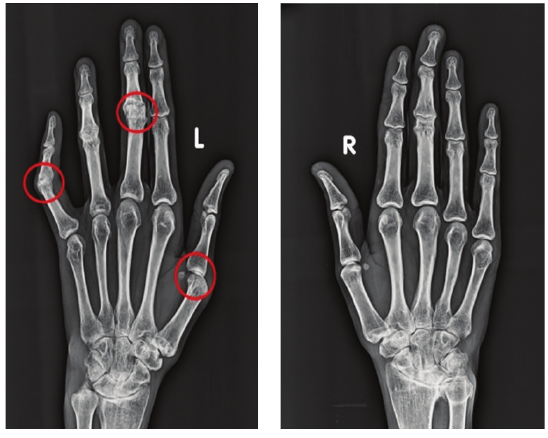
Figure 9: Hand wrist radiograph showing periarticular osteoporo- sis of interphalangeal joints of